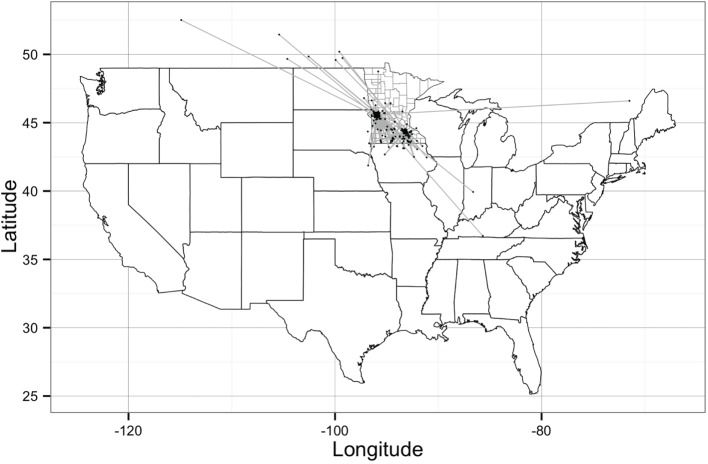
Geographical representation of the Stevens network and Rice network of animal movements between swine farms and/or market sites. Dots represent geographical location of sites and straight gray lines represent animal movements. [Source: Wayne (27)].